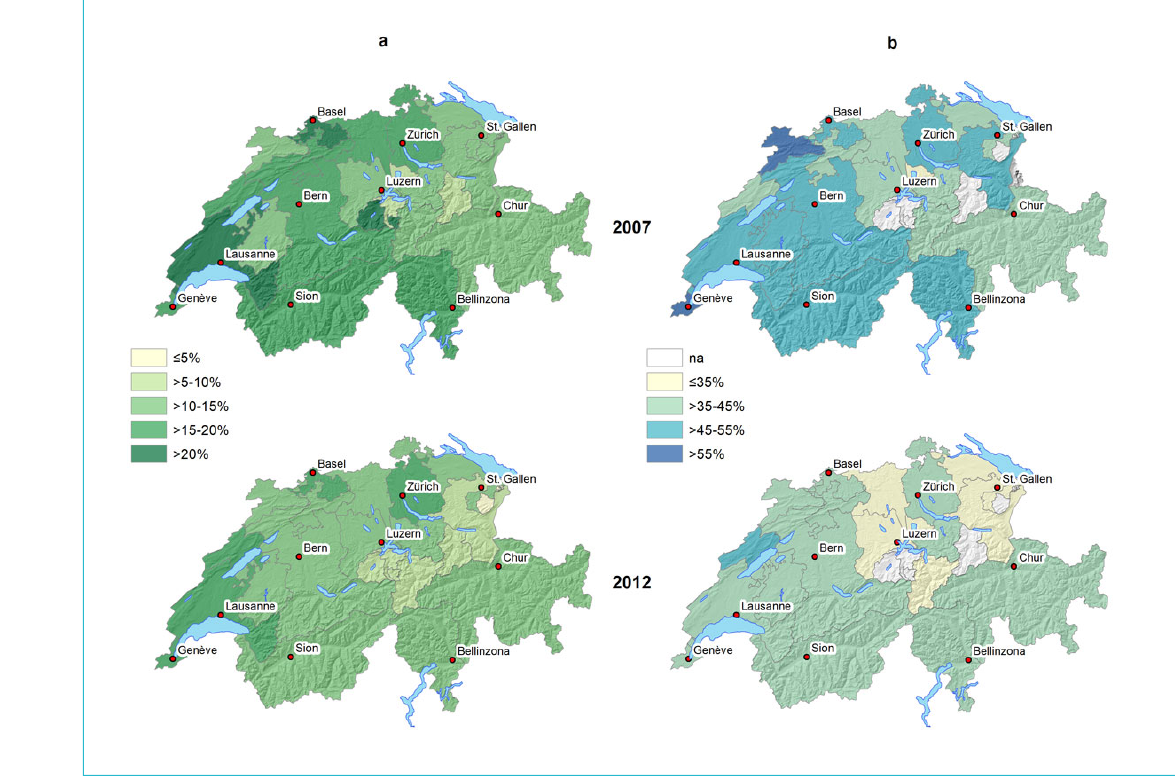
Figure 1: Geographical distribution of people reporting having been vaccinated for influenza in the last 12 months in Switzerland, 2007 and 2012. Panel A, overall; panel B, people aged ≥65 years. na = not applicable (no. of respondents